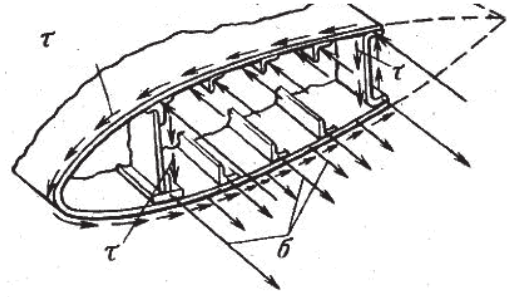
Figure 1: Stresses in the wing components.